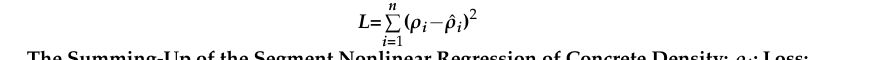
Table 14. The results of estimating the structural parameters of the segment nonlinear regression model.